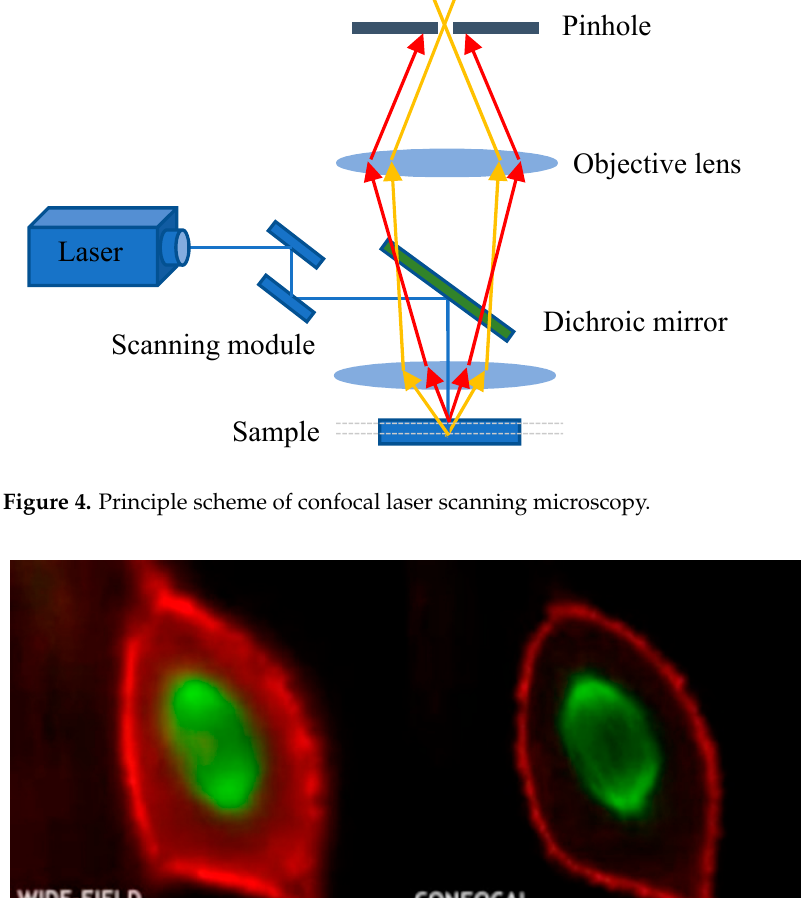
Figure 5. Conventional microscopy vs. confocal microscopy (reproduced with permission from the National Institute of Biological Sciences, Beijing).